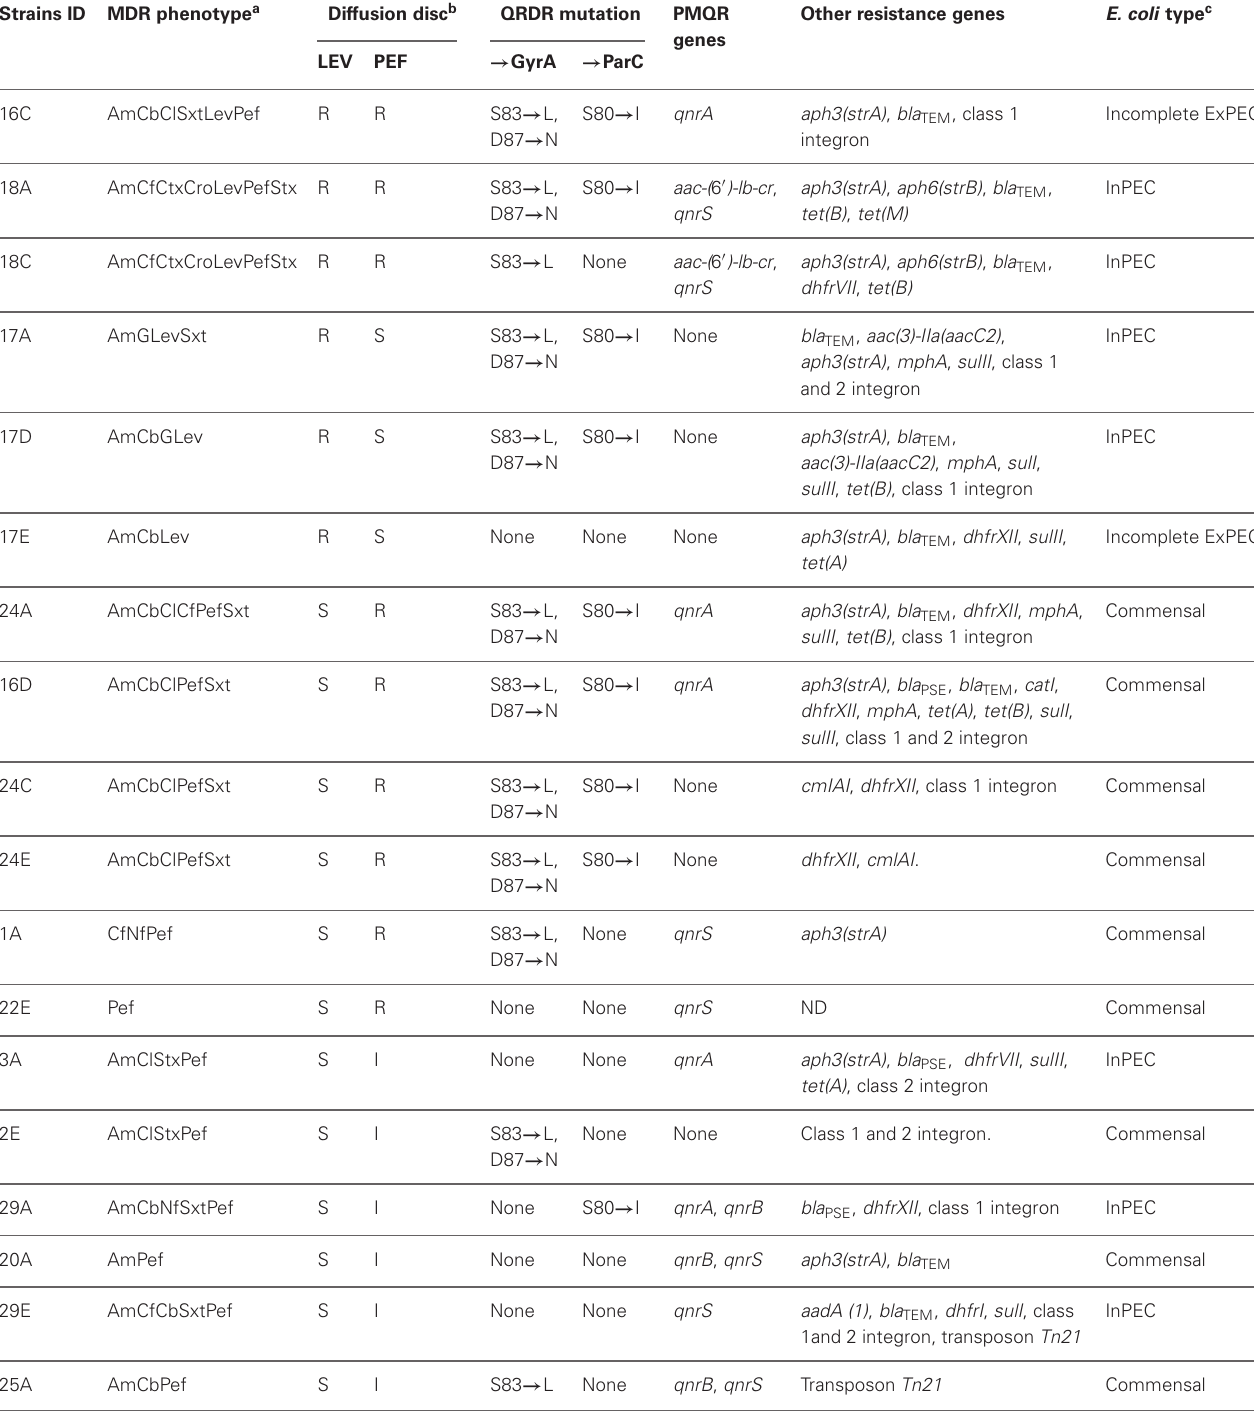
Table 6 | Summary of the pathotype, antimicrobial resistance patterns, QRDR mutation and presence of qnr resistance genes for the 18 E. coli isolates selected for their resistance to fluoroquinolones of second (pefloxacin) and third (levofloxacin)